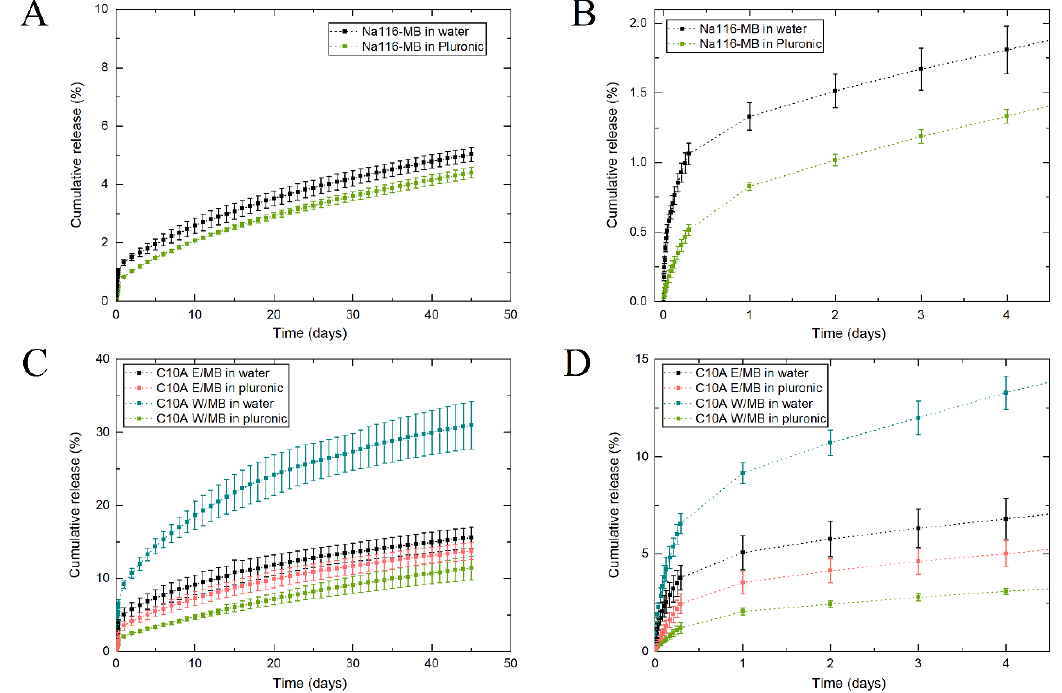
Figure 11. ( A ) MB release profile from Na116-MB hybrid with the initial burst release. ( B , C ) MB release profile from C10A-MB hybrid prepared in water (C10A W) and ethanol (C10A E) with the initial burst release ( D ). In both cases, release studies were performed by adding the clay–MB hybrid to either a water or Pluronic formulation (F127/F68 18/2 wt.%). The results are expressed as average ± standard deviation for three independent experiments.